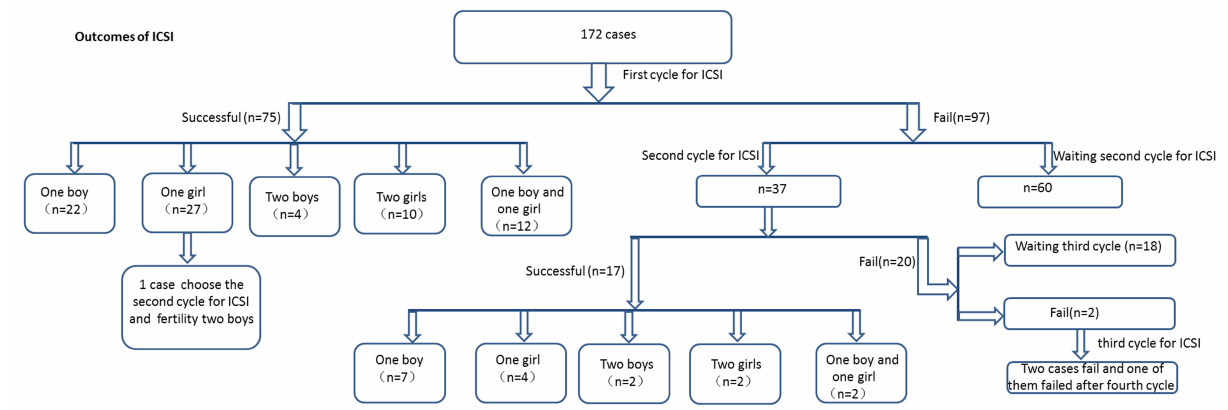
Fig. 2. Fertility outcomes in ICSI cycles in couples with CBAVD.